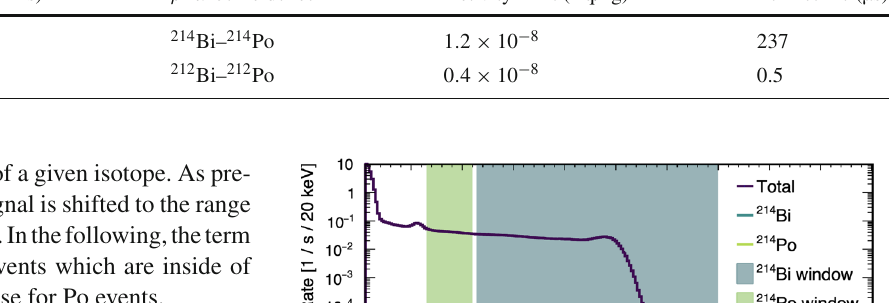
Table 6 Basic parameters of Bi–Po coincidence decays and their link to U/Th concentrations Decay chain